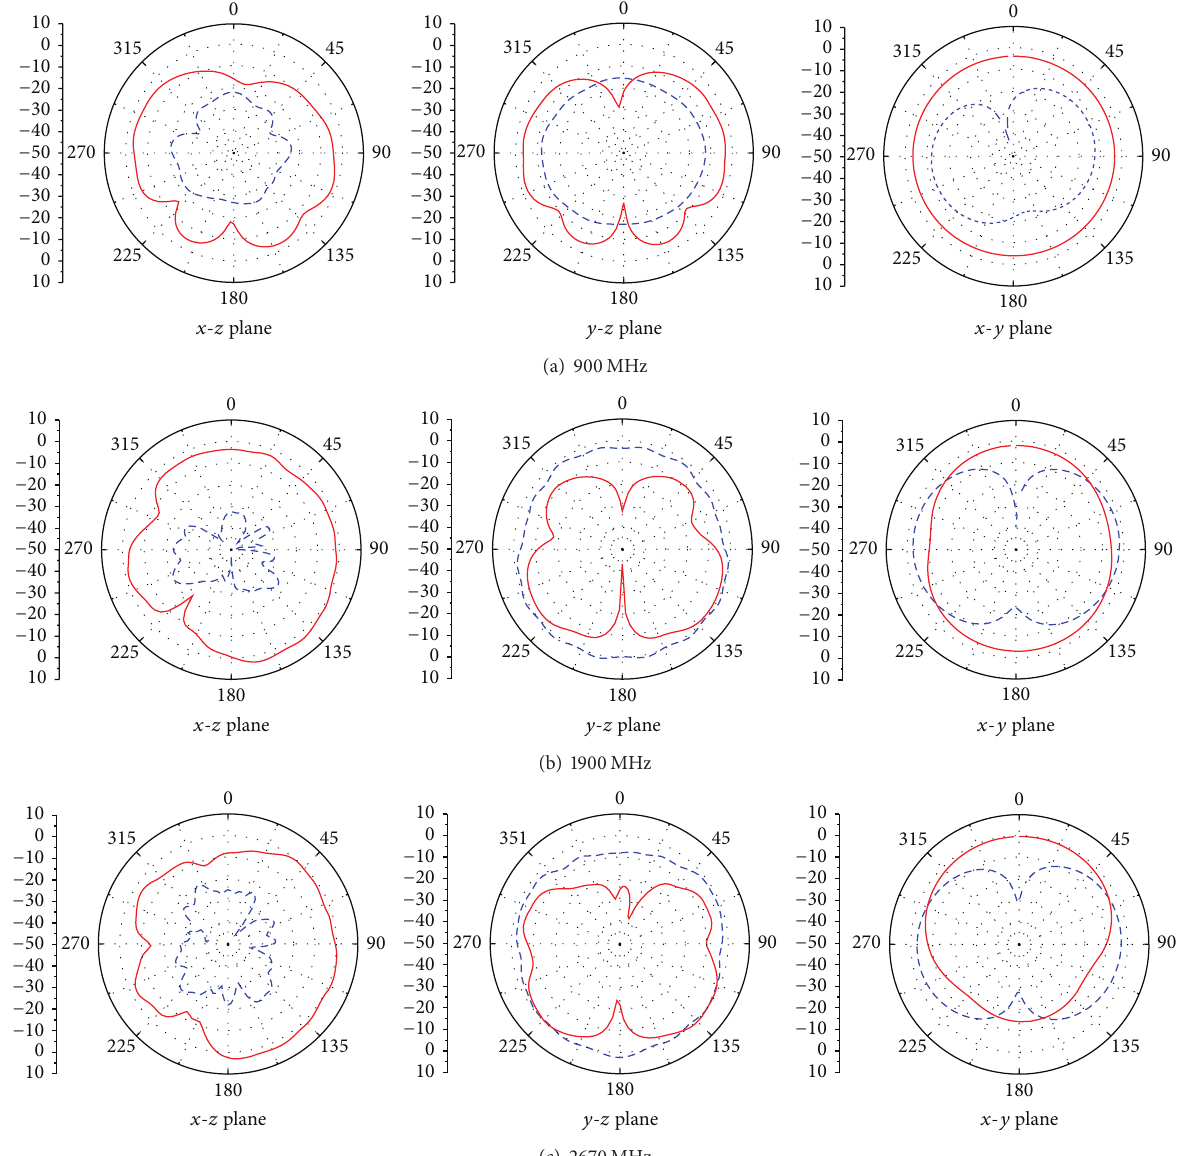
Figure 8: Measured 2-D radiation patterns at (a) 900MHz, (b) 1900 MHz, and (c) 2670 MHz for the fabricated antenna (dotted line is 𝐸 𝜑 , and solid line is 𝐸 𝜃